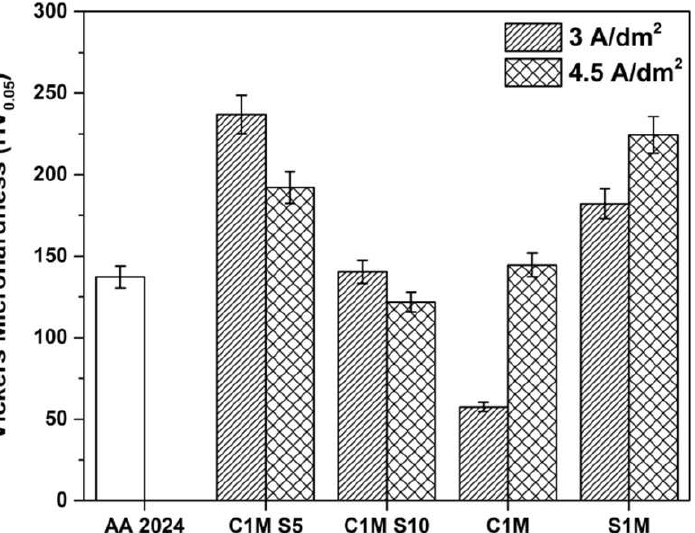
Figure 7. Vickers microhardness measurements of non-anodized and hard anodizing AA2024 samples at 3 and 4.5 A/dm 2 .